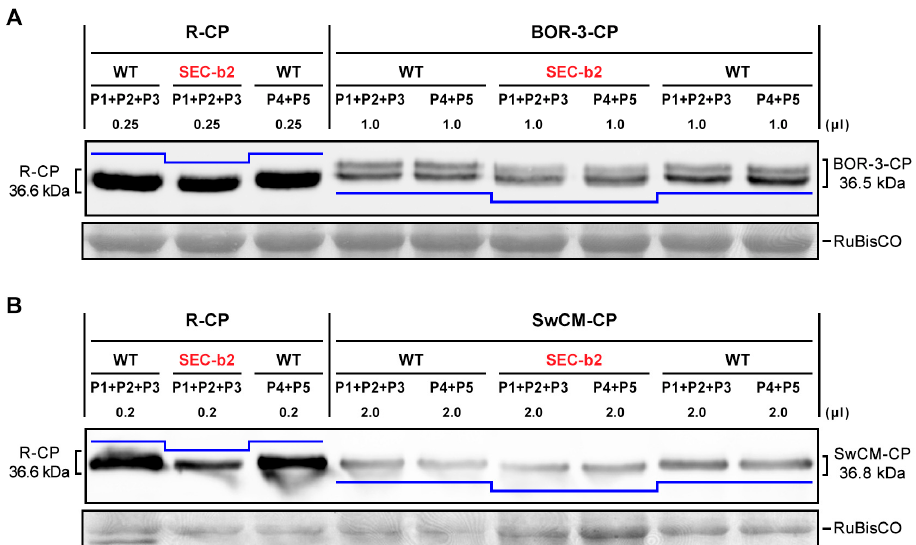
Figure 3. Electrophoretic mobility of the coat protein (CP) of different Plum pox virus isolates: PPV-R (R-CP) ( A,B ), PPV-BOR-3 (BOR-3-CP) ( A ), and PPV-SwCM (SwCM-CP) ( B ), obtained from Nicotiana benthamiana plants, wild-type (WT), and SEC-deficient transgenic plants (SEC-b2). Crude extracts were prepared from systemically infected leaves collected at 17 days post-infection in native conditions and subjected to SDS-PAGE and Western blot anti-CP. Pools of analyzed plants (P1 to P5) and loaded extract volumes are indicated. Blots stained with Ponceau red showing the ribulose-1,5-bisphosphate carboxylase/oxygenase (RuBisCO) large subunit are included as loading controls. Differences in electrophoretic mobility for CPs from WT and SEC-b2 plants are represented with blue lines. This result indicated that the CP of viruses belonging to three different PPV strains was susceptible to be O -GlcNAcylated, and this modification was carried out by SEC enzyme.